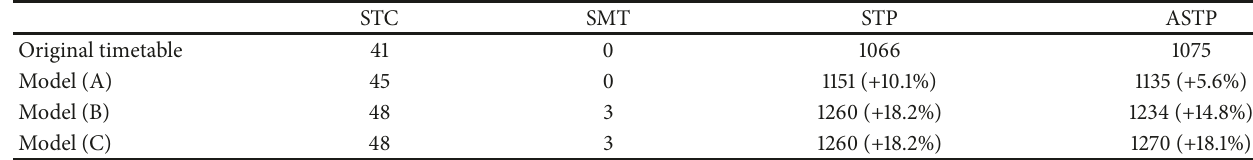
Table 2: The transfer accessibility of the optimized last-train timetables.